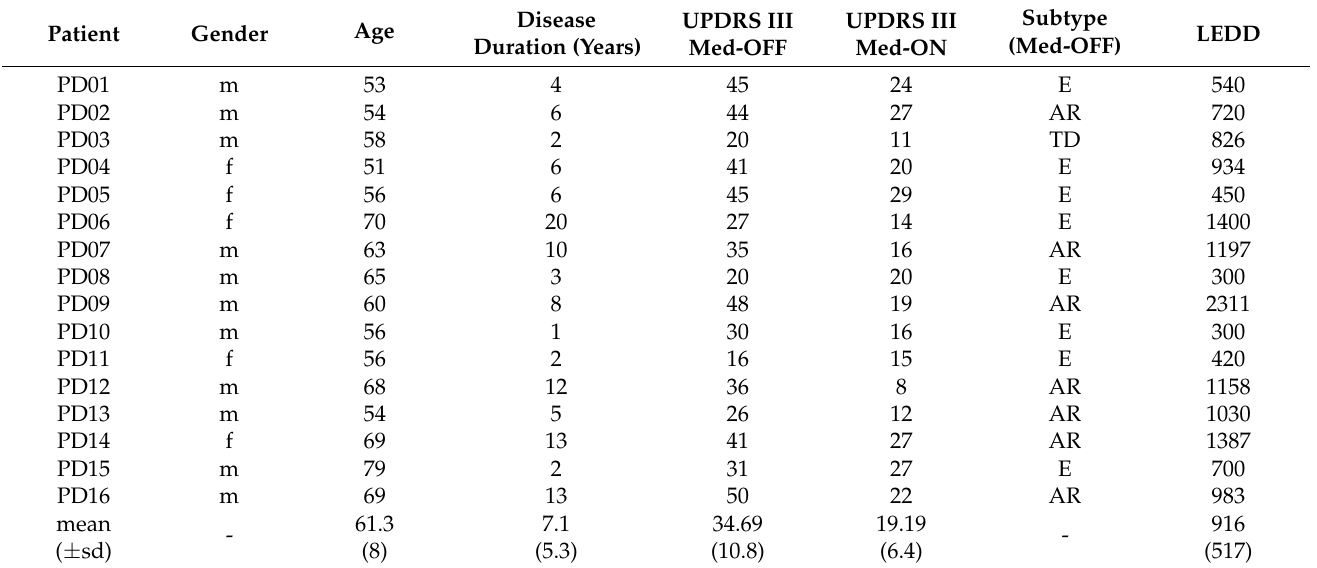
Table 1. Patients’ demographic and clinical characteristics. In addition, information about the PD subtype (AR = akinetic- rigid, E = equivalent, TD = tremor-dominant) and levodopa daily dose (LEDD